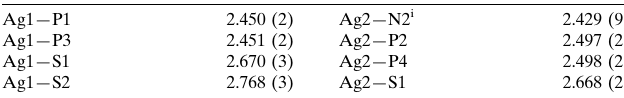
Bruker SMART CCD area-detector diffractometer Absorption correction: multi-scan ( SADABS ; Bruker, 2007)